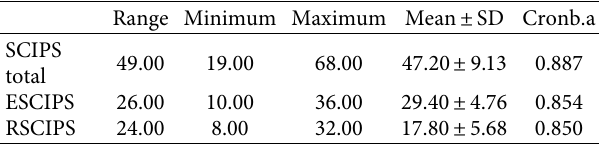
Table 3: Items loadings in factor analysis of the spiritual care intervention-provision Scale ( n �